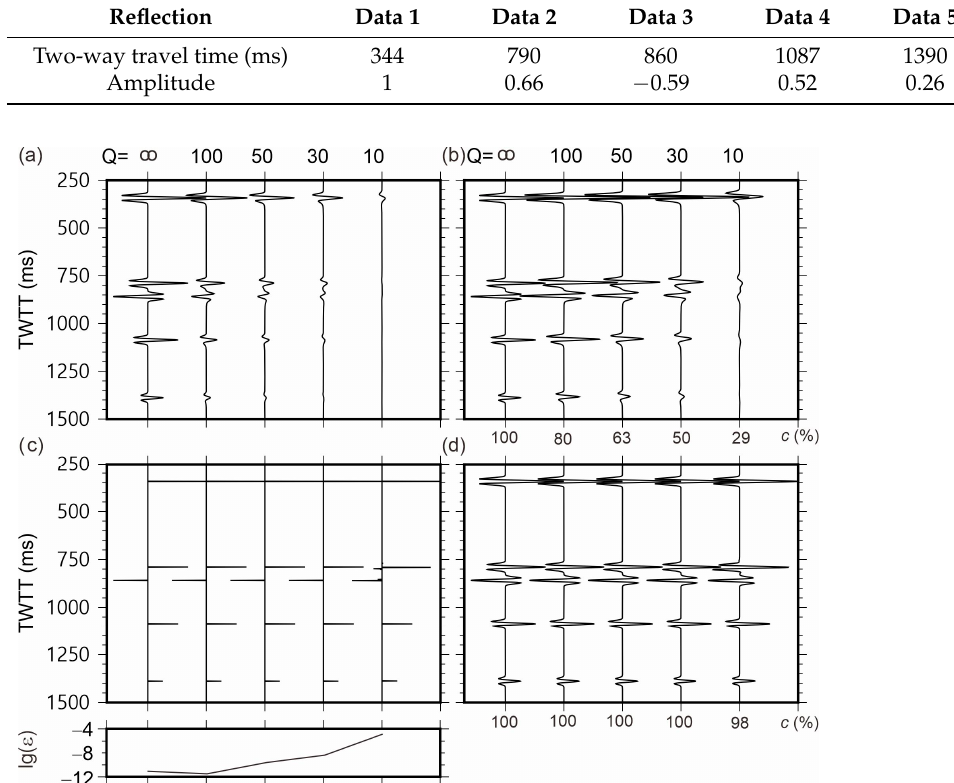
Table 1. Reflection amplitude model for numerical experiments.